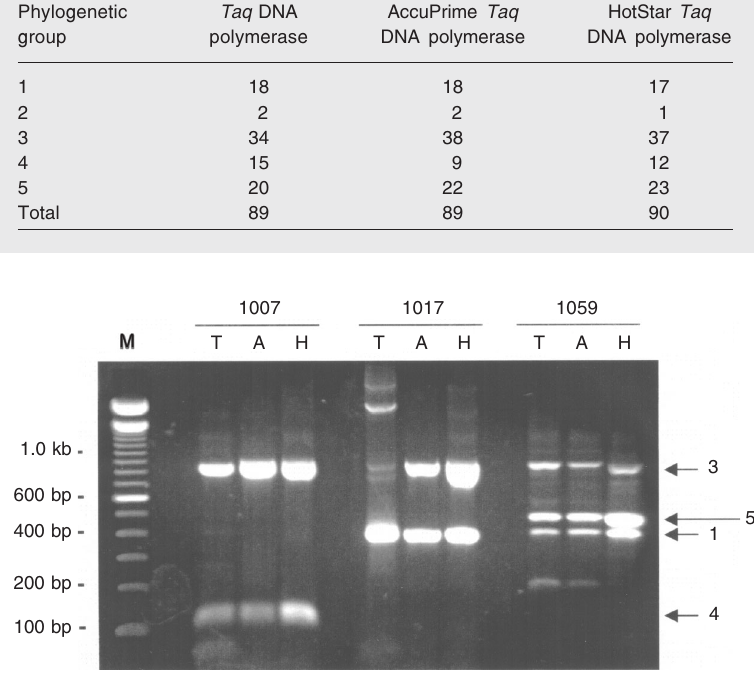
Table 2. Number of Torque teno virus phylogenetic groups detected with three different thermostable DNA polymerases in multiplex PCR (55 samples analyzed). Phylogenetic